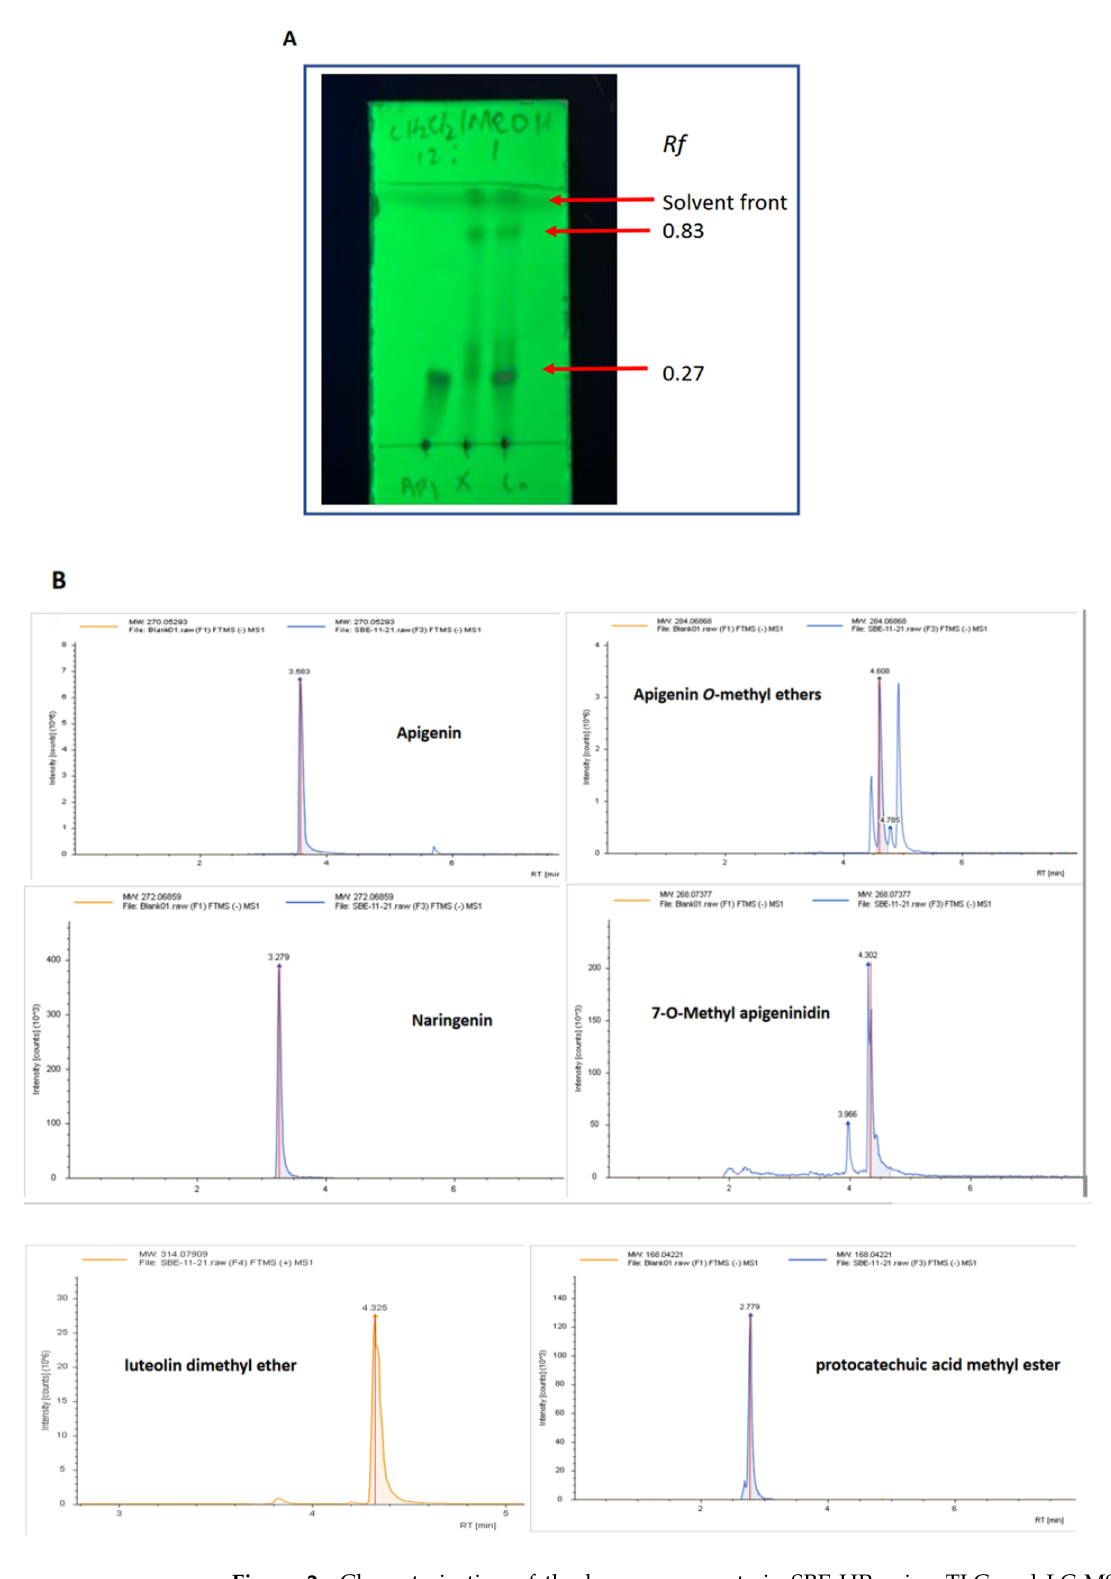
Figure 2. Characterisation of the key components in SBE-HP using TLC and LC-MS analyses. ( A ) TLC analysis on a normal phase silica plate, eluted with CH 2 Cl 2 /MeOH 12:1, revealed that SBE-HP separated into three clusters with RF s of 0.27, 0.83, and approx. 1. ( B ) LC-MS traces of key compounds in SBE-HP. Negative ion mode was presented for